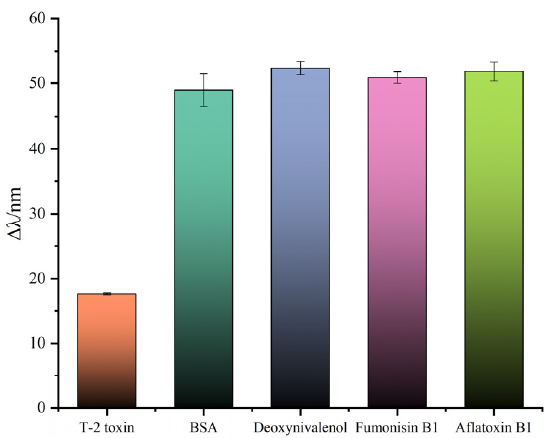
Figure 8. Specificity analysis of SPR biosensors. Table 2. Repeatability analysis of SPR biosensor.